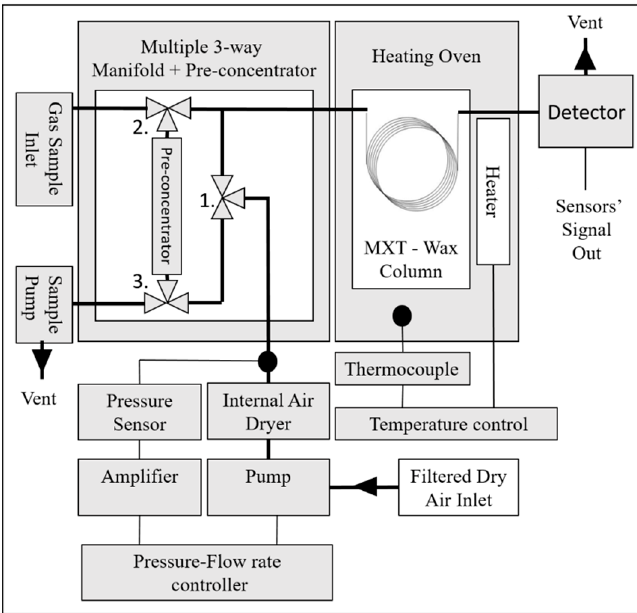
Figure 4. Schematic diagram of the experimental setup.